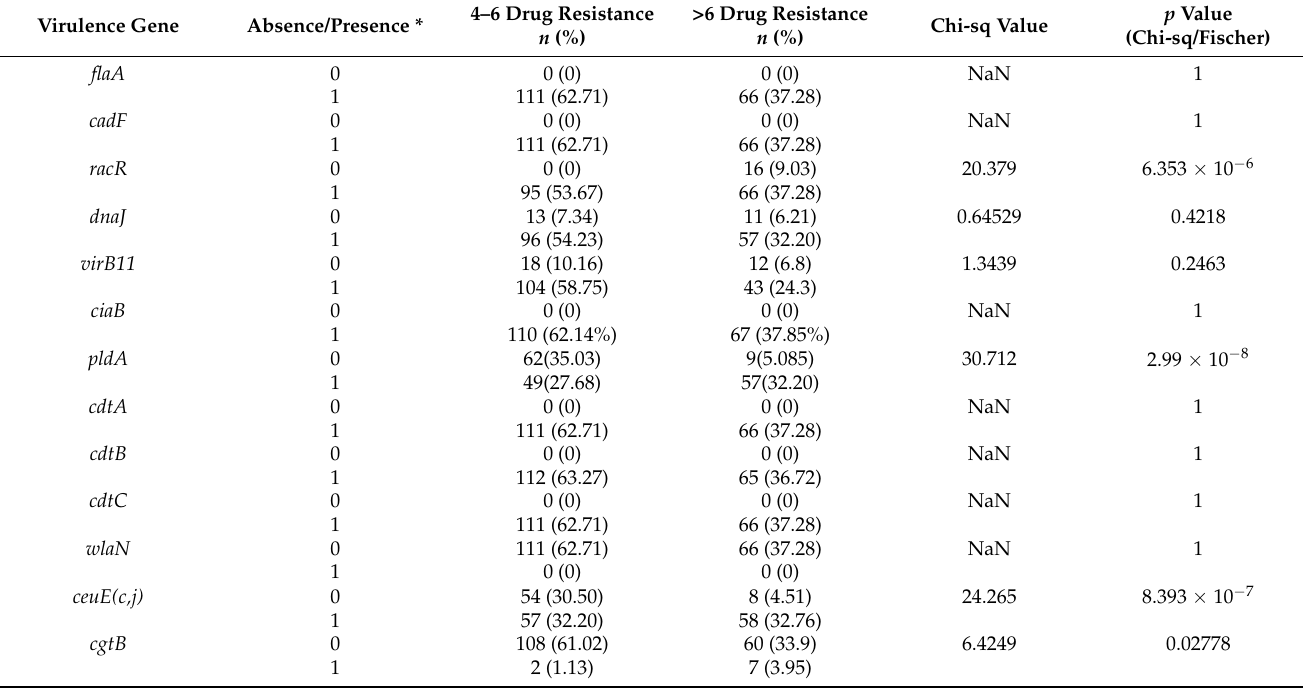
Table 1. Associations between virulence genes and multidrug resistance in Campylobacter isolates ( n = 177).